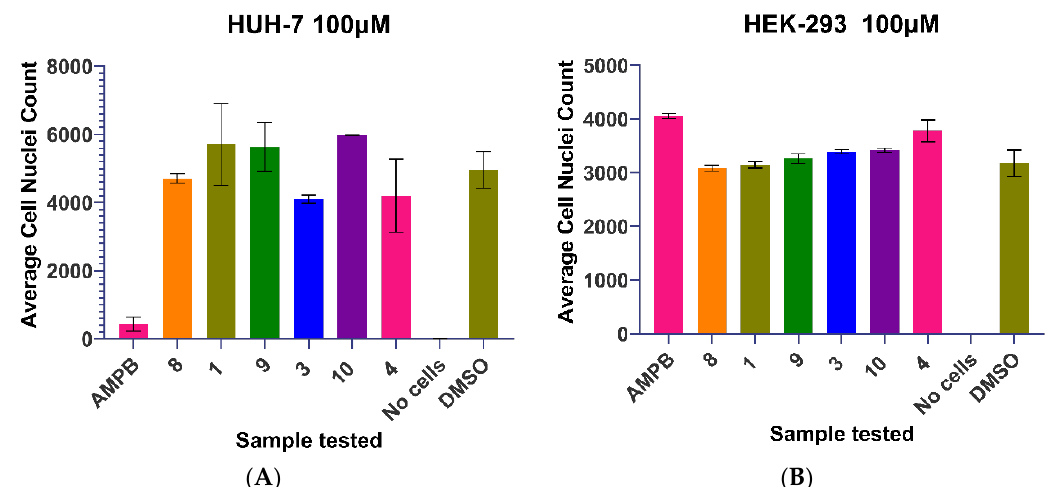
Figure 3. Cytotoxicity testing against mammalian cell lines ( A ) HUH-7, a liver cell line, and ( B ) HEK293, a fetal embryonic kidney cell line. The results indicate very low cytotoxicity of compounds tested. AMPT is amphotericin B.